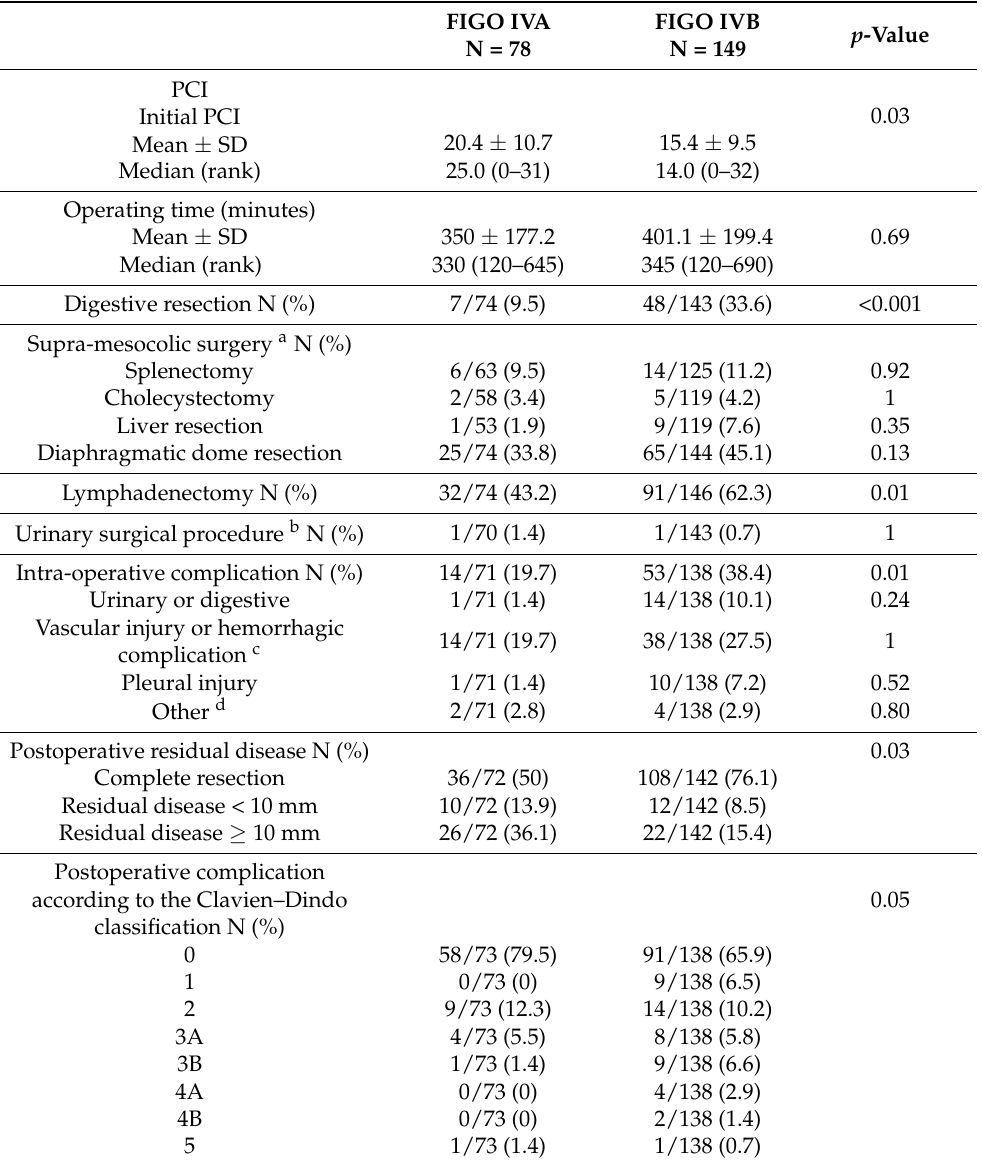
Table 3. Characteristics of surgery for operated patients according to FIGO stage IVA or IVB. a : colec- tomy including posterior pelvectomy, b : partial or total cystectomy, JJ stent, c : vascular injury or bleeding complication requiring transfusion of red blood cells, d : splenic, hepatic or biliary tract injury. FIGO